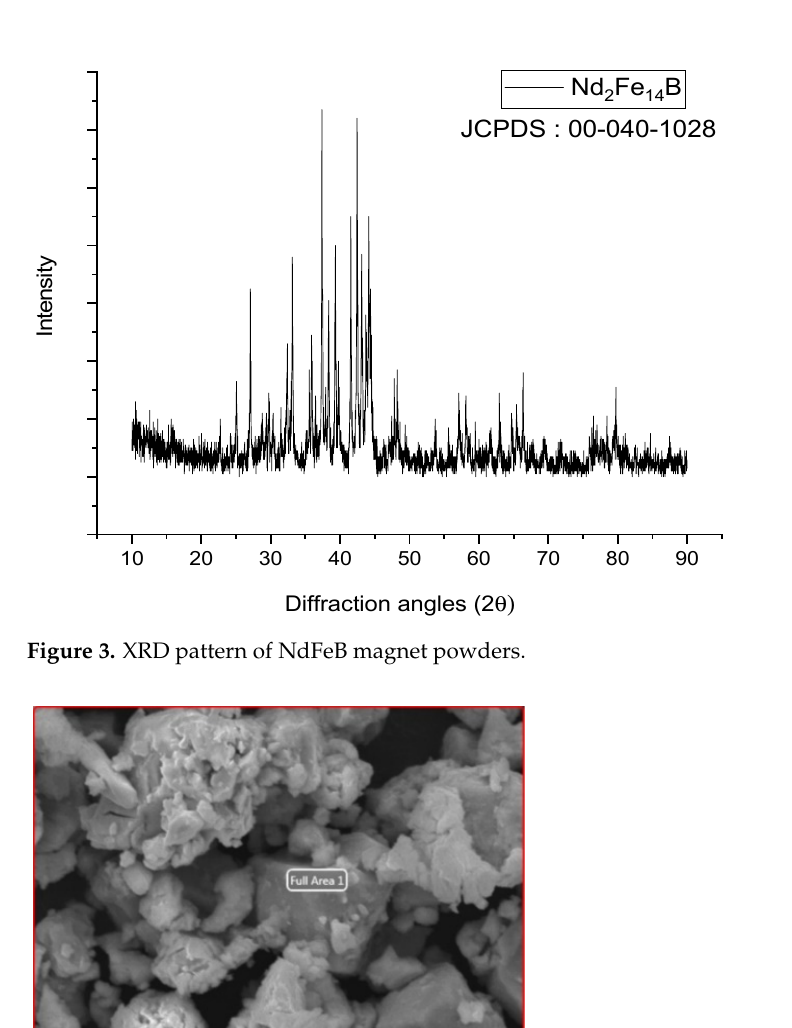
Figure 4. SEM analysis of NdFeB magnet powders.